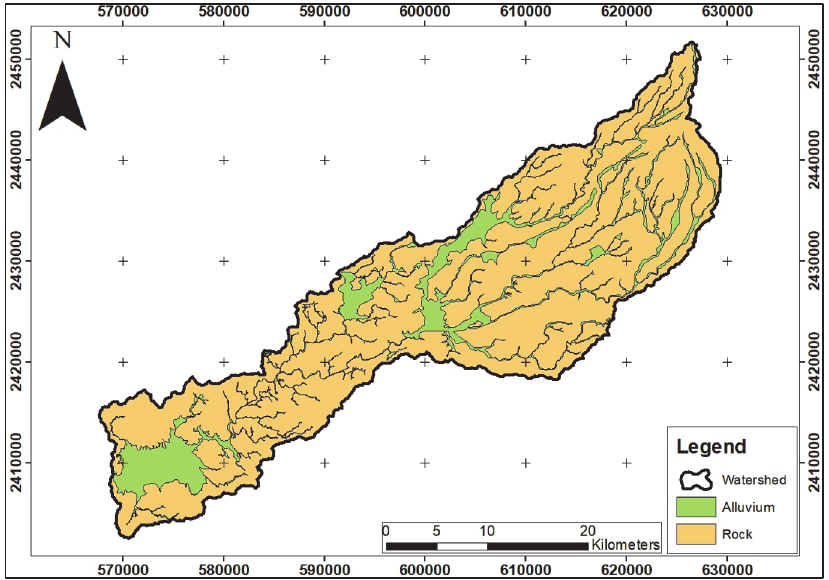
Figure 10. Dimensionless cumulative hyetograph, first quartile for Jeddah City (Elfeki et al., 2014).